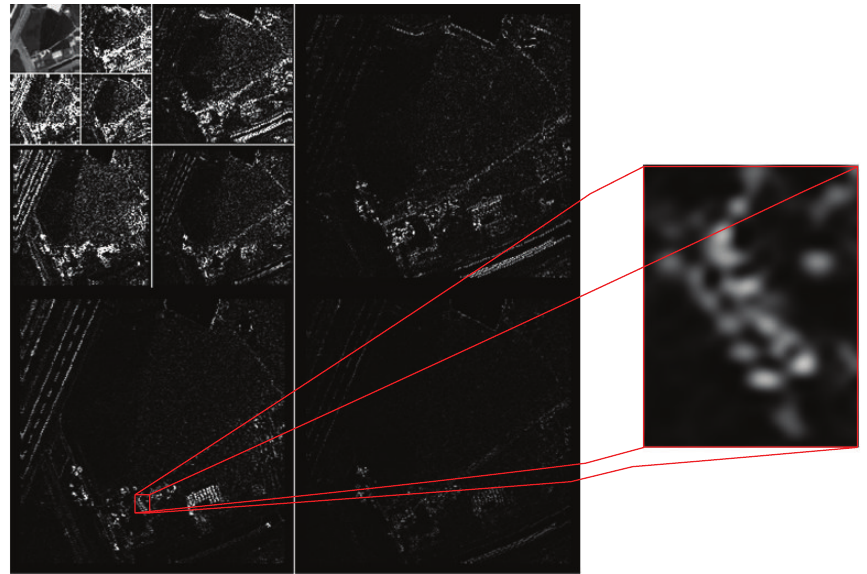
Figure 4: The wavelet transform of high resolution image with a zoom on some